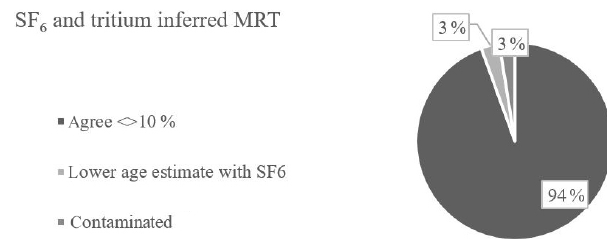
Figure 7. Agreement of SF 6 and tritium inferred MRTs. The data suggest that for most sites SF 6 inferred MRTs match tritium inferred MRTs. Only few sites (3%) were contaminated with SF 6 , and an- other 3% showed lower age estimates with SF 6 than with tritium, which could result from a thick unsaturated zone and associated travel time to the